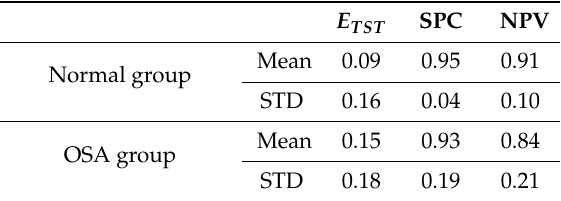
Table 3. Effect of image enhancement (IE) for the performance improvement of the error of total sleep time.